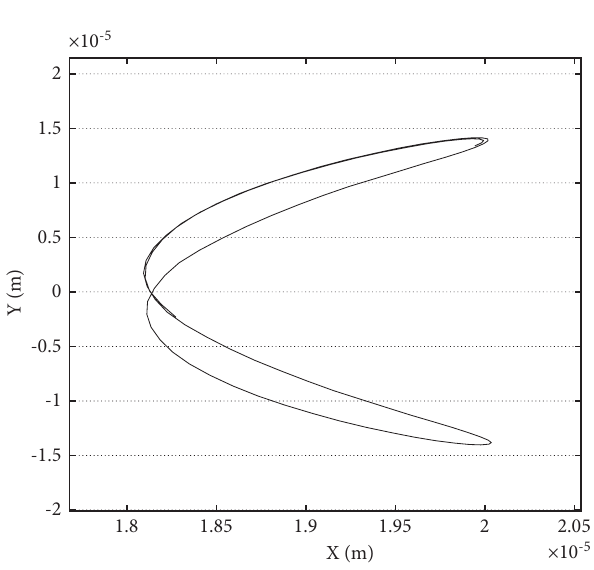
Figure 12: Vibration displacement